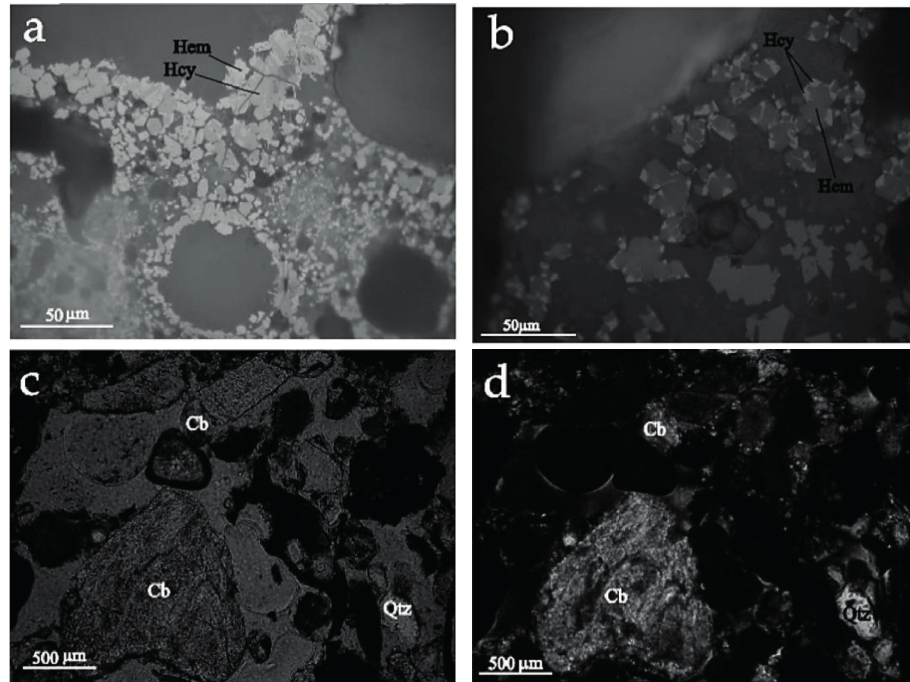
Figure 3: The healing of tendon injury was obtained by medical image